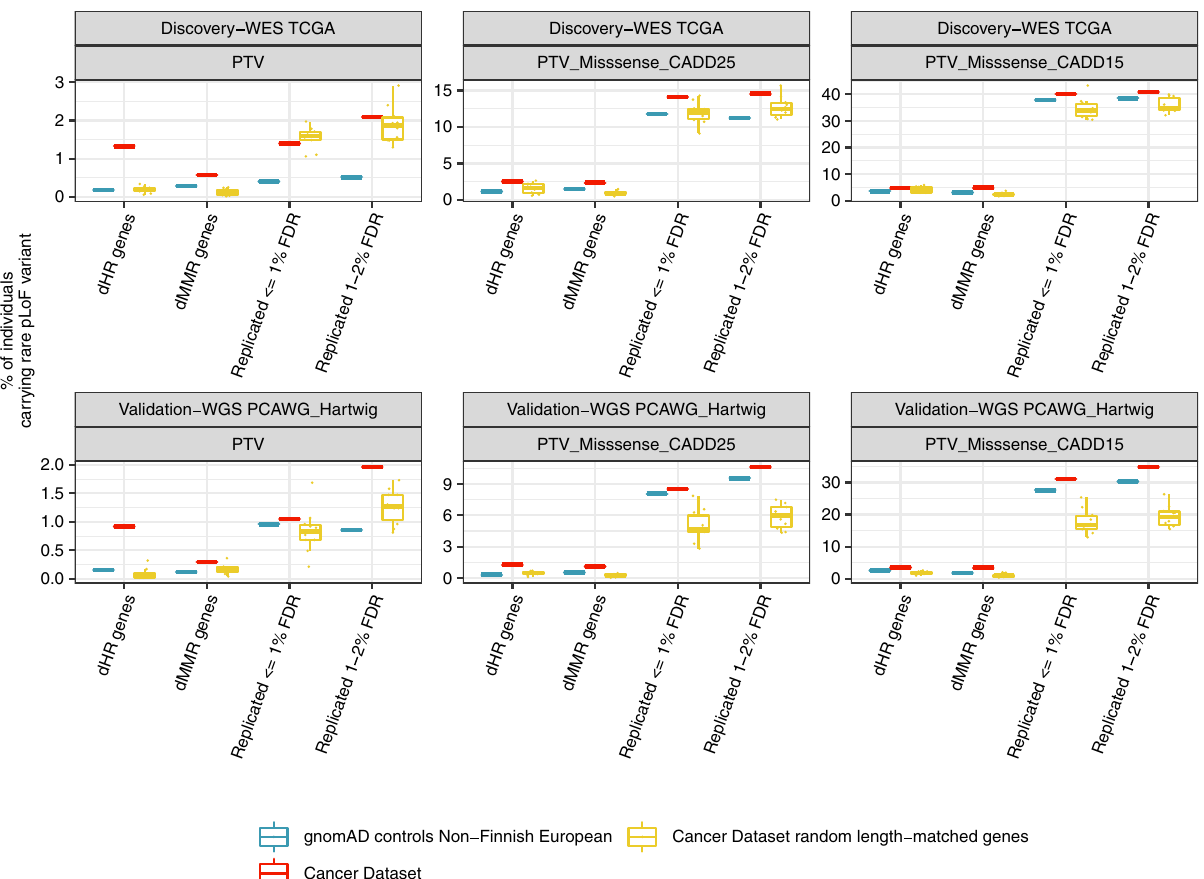
Fig. 5 Frequency of rare putative loss-of-function (pLoF) variants across cohorts in comparison to individuals from gnomAD. The frequencies of rare pLoF variants within the individuals ( y -axis) of the discovery cohort (TCGA-WES; n = 6799 individuals) and the validation cohort (PCAWG + Hartwig- WGS; n = 4683 individuals) (rows) across different variant sets (columns) for different gene sets ( x -axis). Known de fi cient homologous